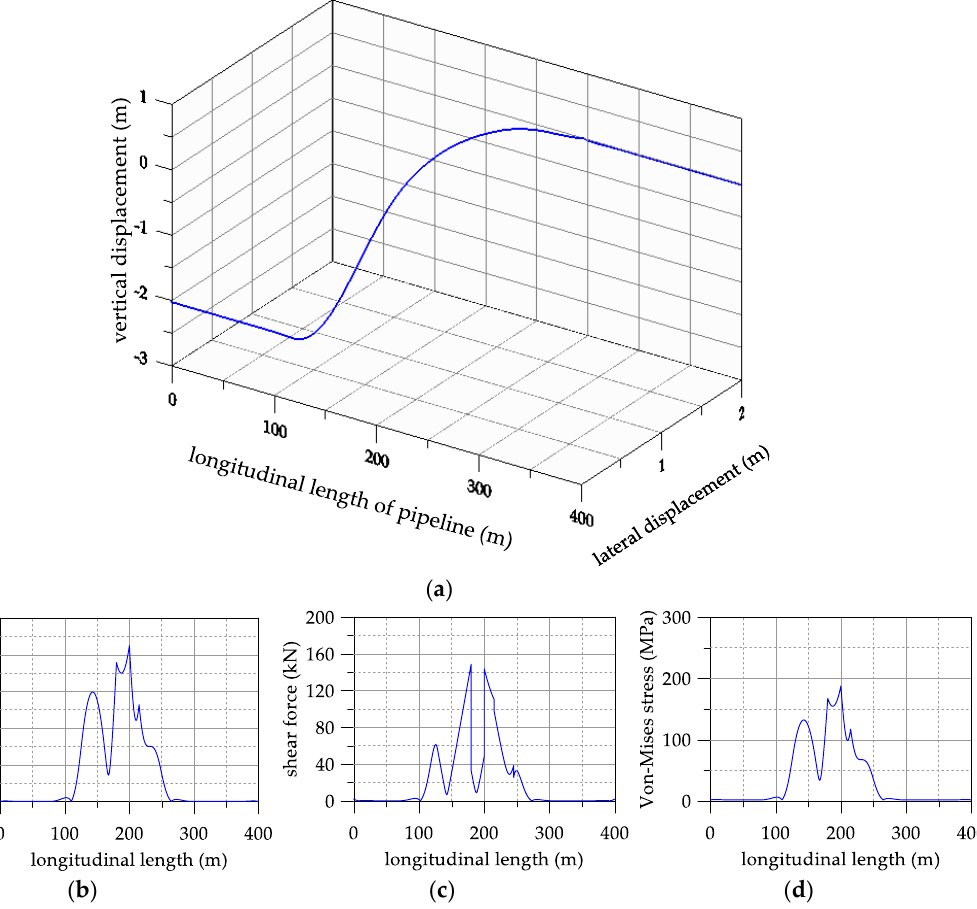
Figure A4. Analysis results of the segmental pipeline model in the lateral plane: ( a ) deflections; ( b ) bending moments; ( c ) shear forces.